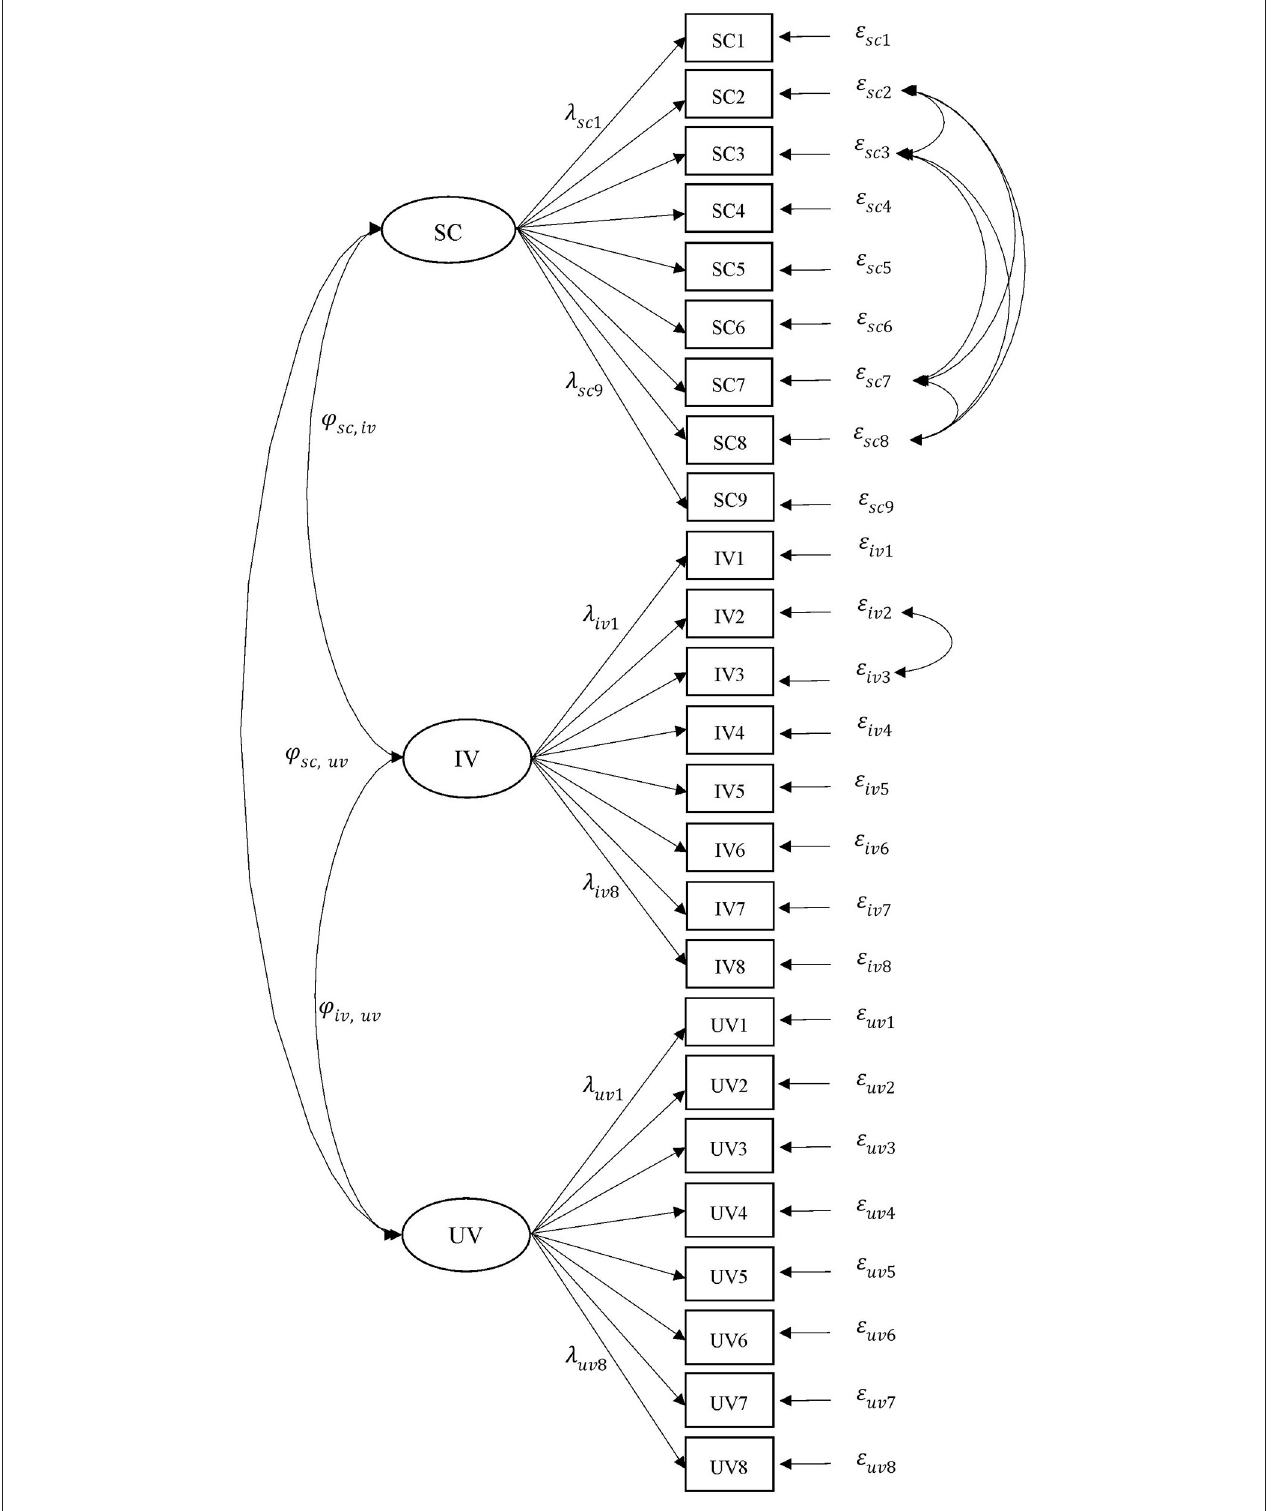
FIGURE 1 | The measurement model for the three-factor model of science motivational beliefs. SC, self-concept; IV, intrinsic value; utility value; φ , correlation; λ , factor loading; ε , residual. The relations among residual terms (e.g., ε iv 2 ←→ ε iv 3 ) were used to estimate the effects of the negative items. For simplicity, only the first (e.g., λ sc 1 ) and the last (e.g., λ sc 9 ) factor loadings for each factor are